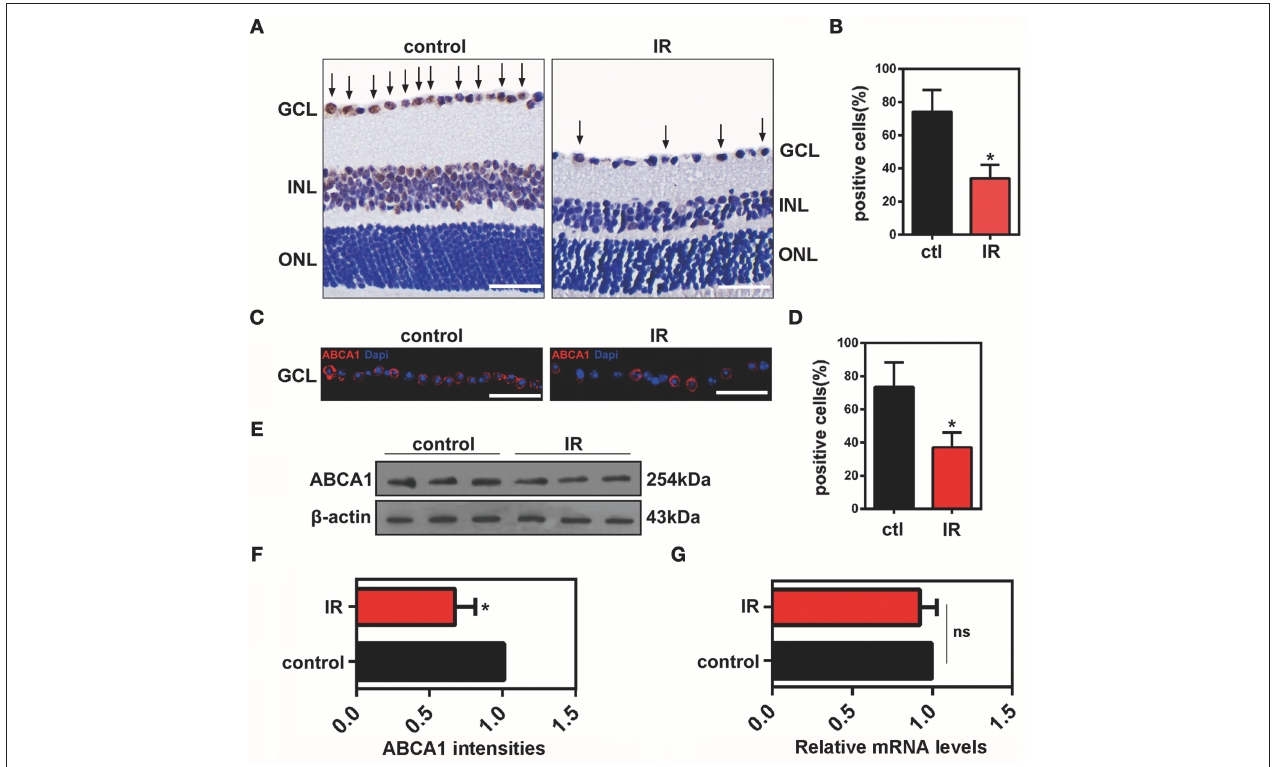
FIGURE 1 | The effects of ischemia-reperfusion on ABCA1 expression in vivo. (A) Representative immunohistochemistry images of ABCA1 expression in ischemic retina slices. Arrows indicate ABCA1-positive cells. GCL, ganglion cell layer; INL, inner nuclear layer; ONL, outer nuclear layer. Scale bar = 50 µ m. (B) Statistical analysis of (A) . The data are presented as the mean ± S.D. ( n = 6 retinas per group). * P < 0.05, unpaired Student’s t test vs. control. (C) Immunofluorescence analysis showing the expression of ABCA1 in a retina after IR. A representative result from three independent experiments is shown. Blue: DAPI; red: ABCA1. Scale bar = 50 µ m. (D) Statistical analysis of (C) .The data are expressed as the means ± S.D. ( n = 6 retinas per group). * P < 0.05, unpaired Student’s t test vs. control. (E) Western blot analysis showing the expression of ABCA1 in a retina after IR. These results were obtained in three independent experiments. (F) Statistical analysis of (E) . The data are expressed as the means ± S.D. ( n = 3 retinas per group). * P < 0.05, unpaired Student’s t test vs. control. (G) RT-PCR analysis of Abca1 gene expression in ischemic retinas 48h after reperfusion. There was no difference between Abca1 mRNA levels in the IR and control groups ( n = 3 retinas per group). P > 0.05, unpaired Student’s t